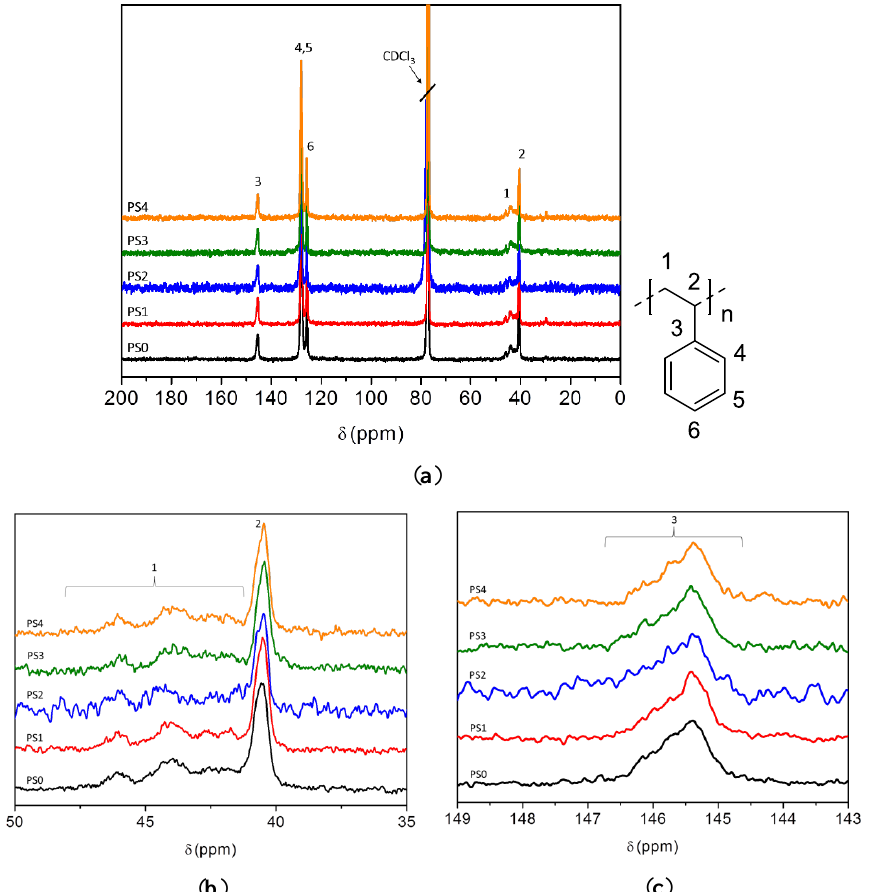
Figure 5. Full stacked proton decoupled 13 C-NMR spectra of the PS0 (original) and PS1–4 (thermally treated) samples ( a ) and ( b ) expansions of the backbone methylene/methine ( c ) and ipso carbon regions 1 H-NMR spectra of the PS1–4 (thermally treated) samples. Labels 1–6 indicate the carbon atoms on